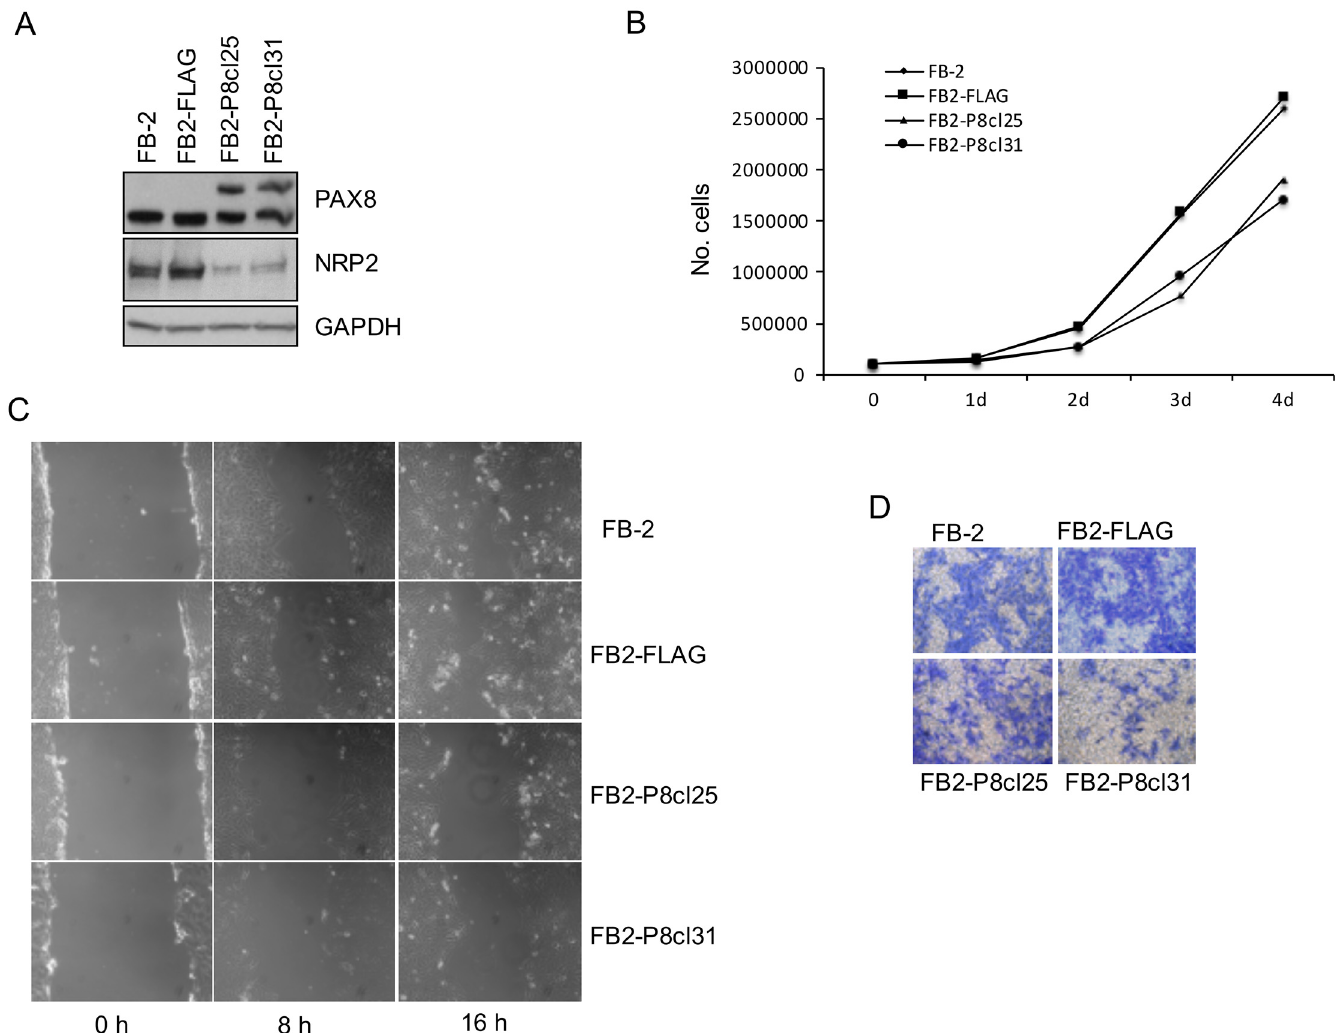
Fig 3. NRP2 downregulation in FB-2 cells inhibits cell proliferation, migration, and invasion. (A) NRP2 downregulation in PAX8 clones was analyzed by Western blot with a specific anti-NRP2 antibody. (B) Growth curves of FB-2, FB2-FLAG, FB2-P8cl25 and FB2-P8cl31 cells are shown. Triplicate of 8 x 10 4 cells were seeded into 60-mm plate. Cell numbers were counted on days 1, 2, 3 and 4 after seeding. (C) Wound-healing migration assay for FB-2, FB2-FLAG, FB2-P8cl25 and FB2-P8cl31 cells were performed. The healing of the wounds by migrating cells was imaged at time 0, 8 and 16 h. (D) Matrigel invasion assay of FB-2, FB2-FLAG, FB2-P8cl25 and FB2-P8cl31 cells. The cells were seeded on 8 μ m pore size Transwell filters and allowed to migrate toward 10% fetal bovine serum. After 16 h, the upper surface of the filter was wiped clean and cells on the lower surface were stained and photographed. This figure is representative of three independent